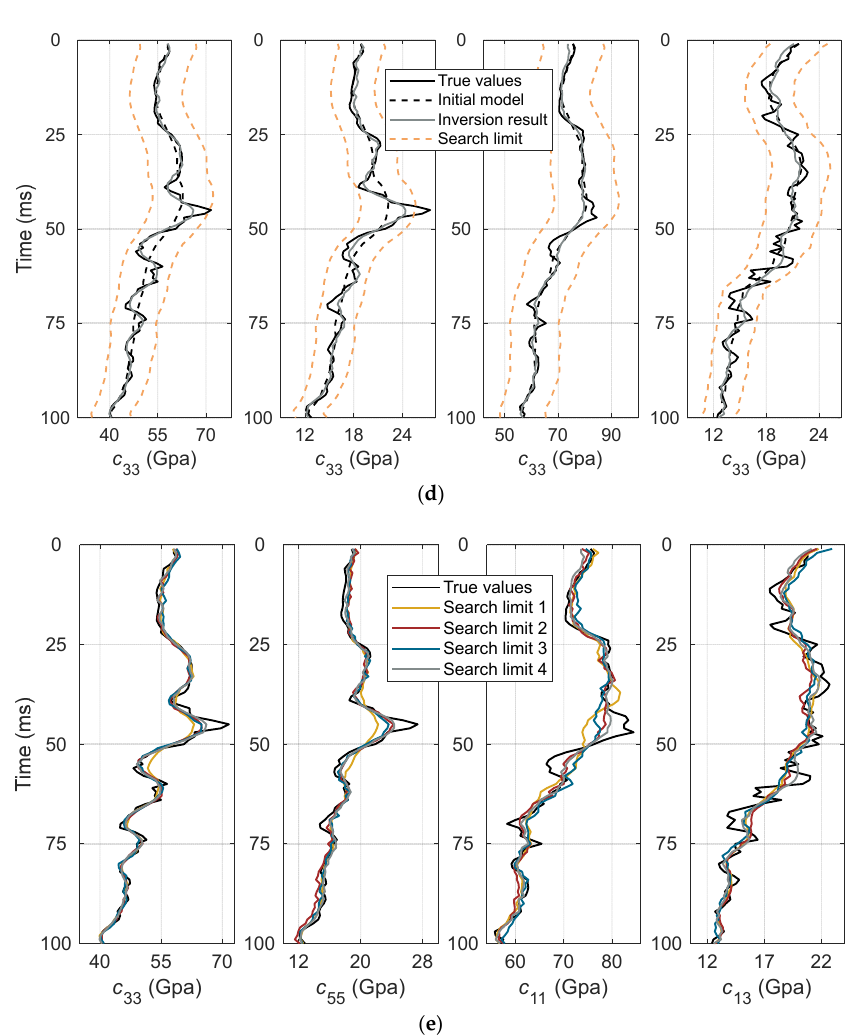
Figure 8. Inversion results with the well model by the FSA optimization at different search limits (the orange dash curves): ( a ) limit 1, a small limit generated with the initial model 1, ( b ) limit 2, a moderate limit generated with the initial model 1, ( c ) limit 3, a large limit generated with the initial model 1, ( d ) limit 4, a moderate limit generated with the initial model 2, and ( e ) the comparison of four sets of inversion results from ( a ) to ( d ). The black solid, black dash, and orange dash curves are the true logs, the initial models, and search limits, respectively. The de fi nitions of inverted curves are given in the legend.